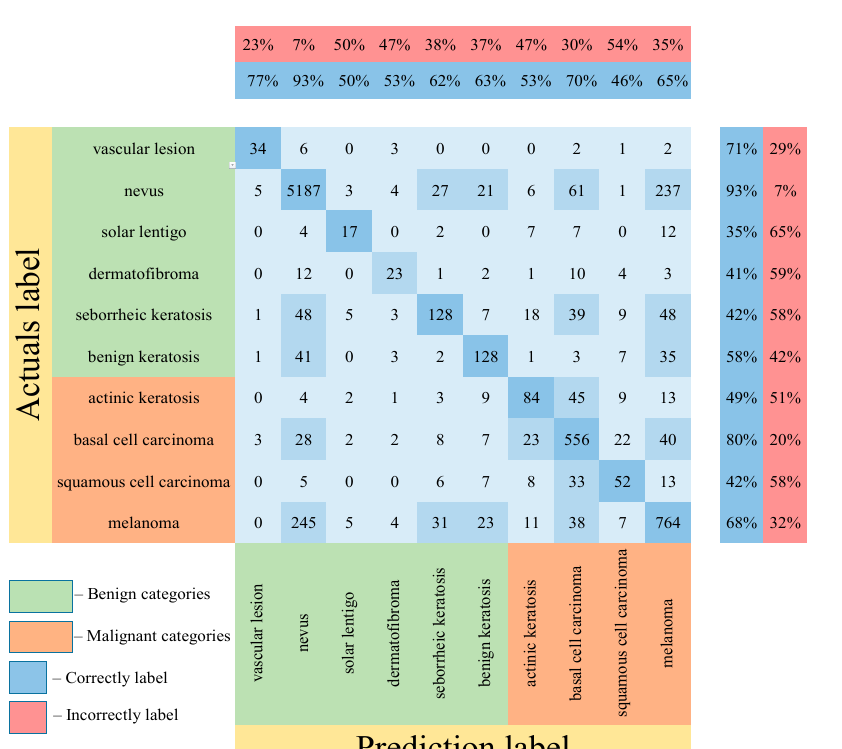
Table 5. Testing results of the proposed multimodal neural network system to recognize pigmented lesions. Bold font indicates the best result in each column of the table.